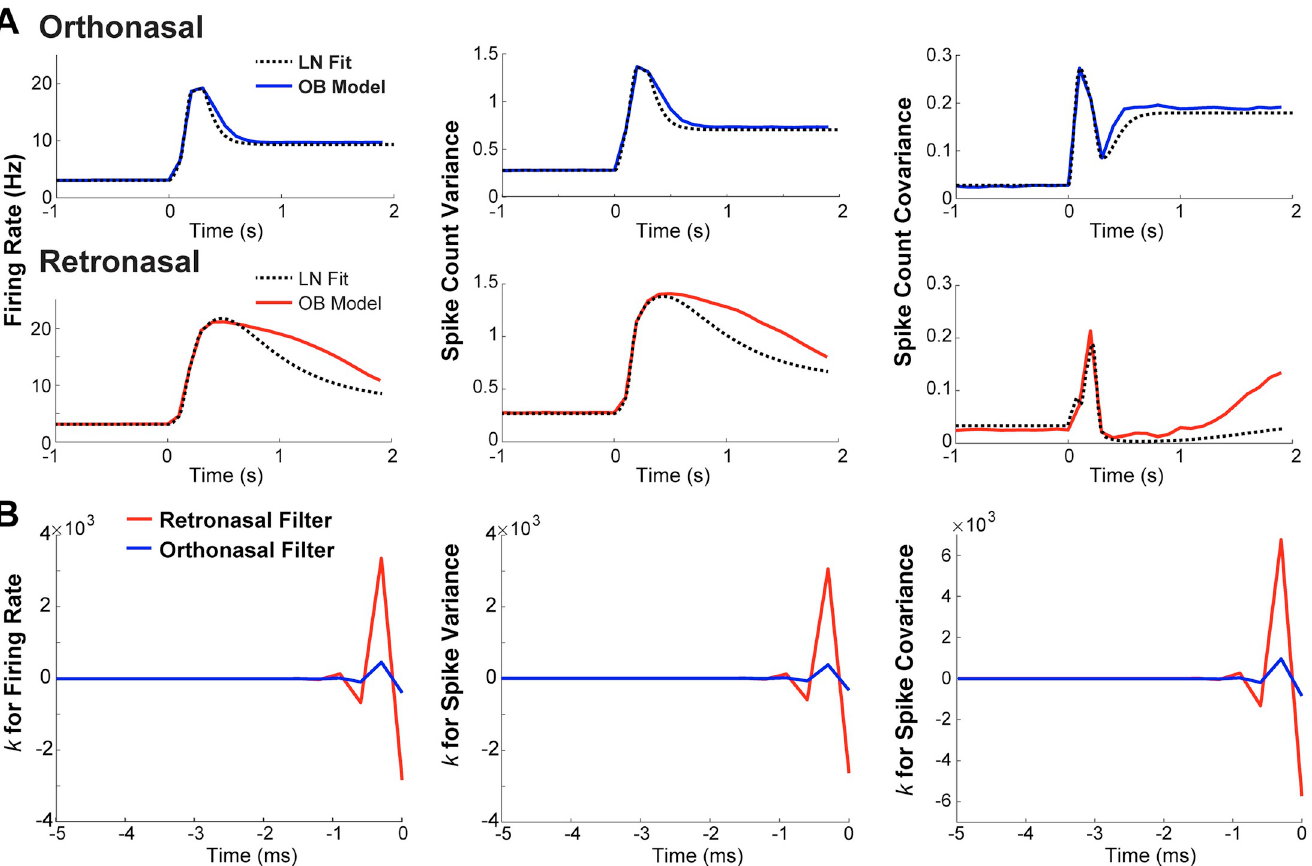
Fig 5. LN model shows that retronasal input results in linear filters with larger magnitudes. A ) Comparison of LN model output (dashed black curves) to OB network model output statistics for ortho (solid blue curves in top panels) and retro (solid red curves in bottom panels) stimulus with onset at t = 0 s. The LN output qualitatively captures OB model output statistics. B ) Linear filters k ( t ) in LN model for ortho (in blue) and retro (in red) stimulus over time ( − 5 � t � 0 ms). Linear filters for retro have larger positive and negative values than with